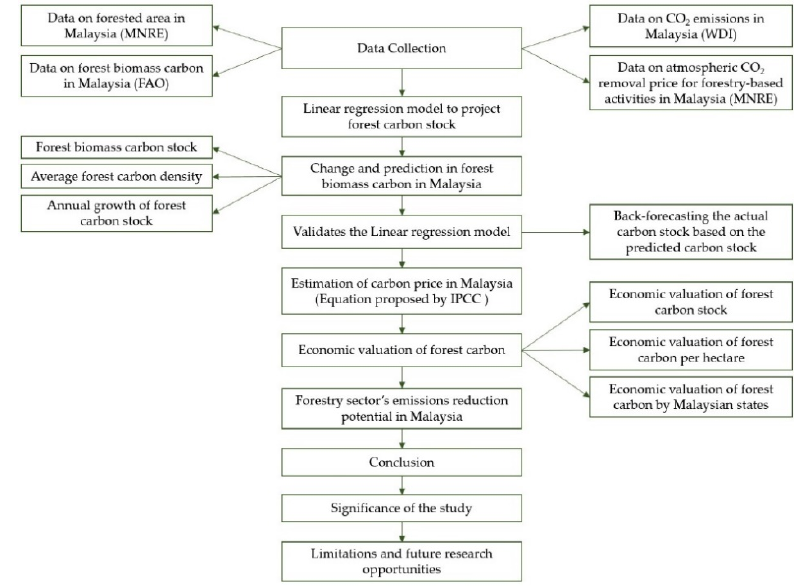
Figure 4. Research design of the study.